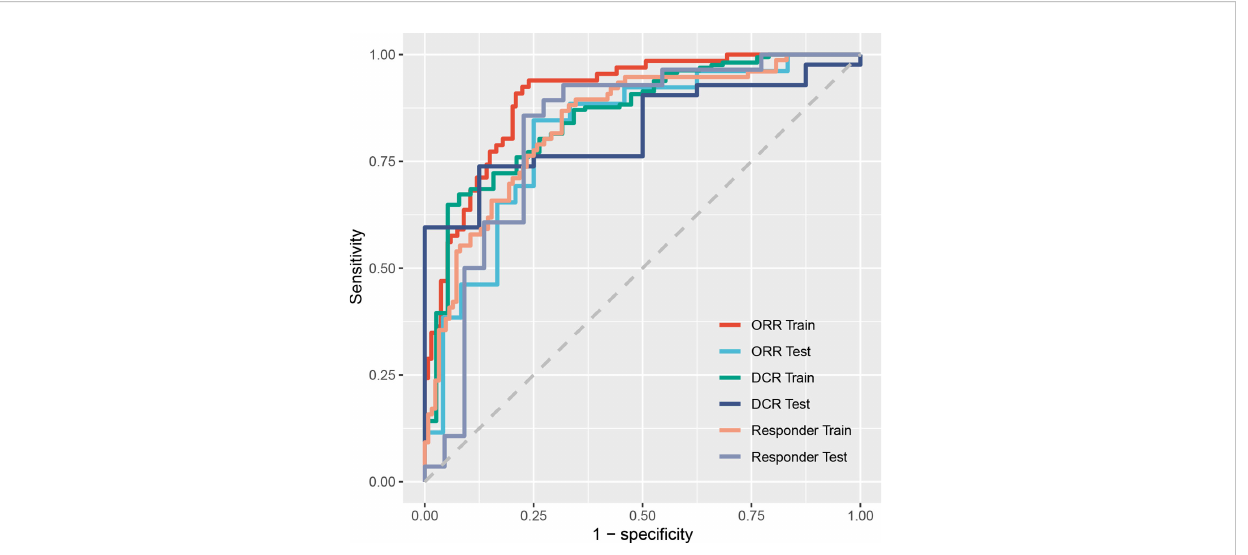
FIGURE 3 Receiver operating characteristic curves of models on predicting ORR, DCR, and responder. ORR, objective response rate; DCR, disease control rate; Responder, progression-free survival time was more than 6